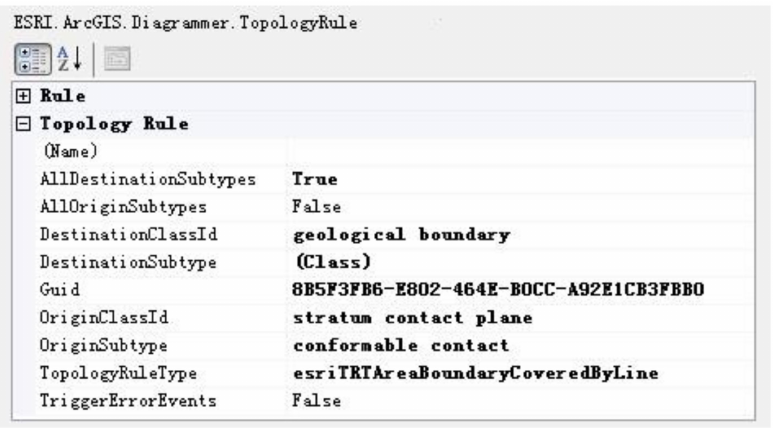
Figure 5. Procedure for building topological rules (an example of a conformable contact